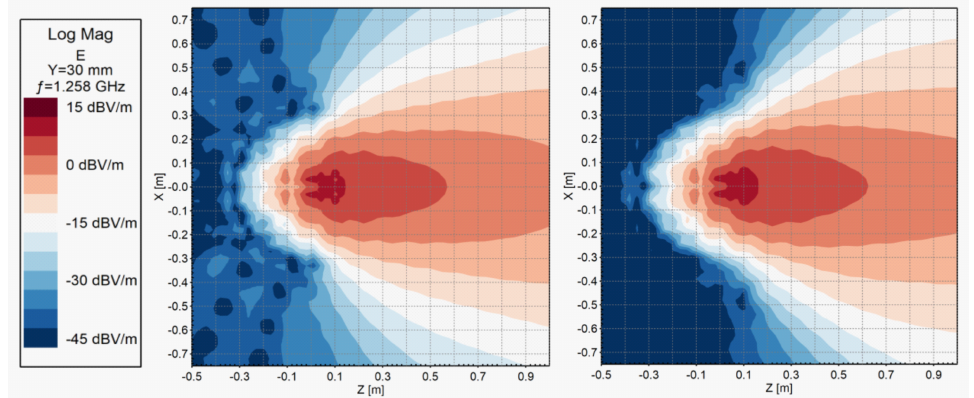
Figure 12. Cut through the electrical near-field at f sel = 1.2575GHz for the horizontal polarization of one VEGA antenna without ( left ) and with choke rings ( right ) derived from far-field measurements in DLR’s CTR. The radiation propagates along Z and the center of the antenna’s aperture is located at Z =